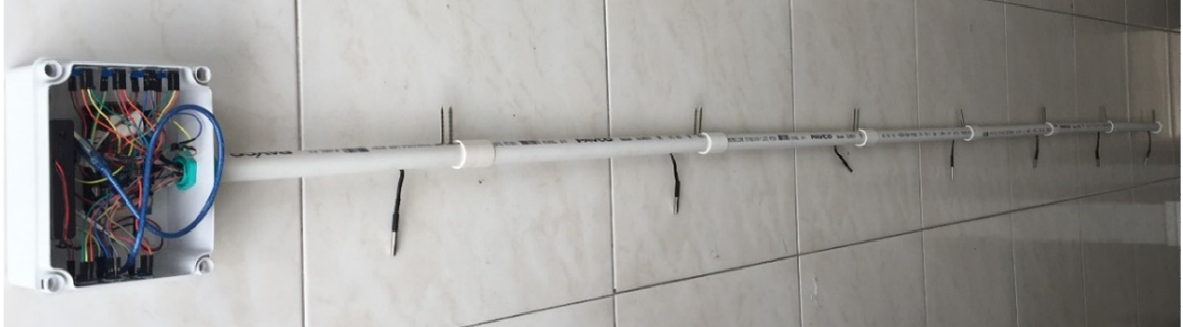
Figure 2. Temperature and humidity measurement device. Temperature and soil moisture content data are measured with an interval of 15 minutes during the most representative weeks for rainy and dry seasons, respectively. Additionally, it is known that soil temperature is influenced by the physical properties of ferent thermal conductivity depending on its VWC . Sand with high VWC has a high ther- mal conductivity. Nonetheless, soils that have a high content of clay or organic materials like shale or coal have low thermal conductivity. For this reason, a sample for each depth is taken and a laboratory texture test is performed (see Figure 3). Figure 3. Samples taken for a laboratory texture test. 2.2. Building Details Generally, the main source of energy consumption in a building is the cooling de- mand in a hot climate. This principally depends on the construction materials, the enve- lope and the glazed surfaces. Other significant factors that influence the building loads